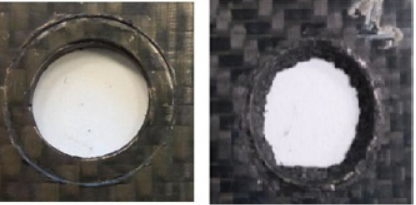
Figure 6. PA66-CF45 plate disassembled at a maximum: ( Left ) Produced by maximum tightening torque. ( Right ) Produced when applied torque is greater than maximum tightening torque.